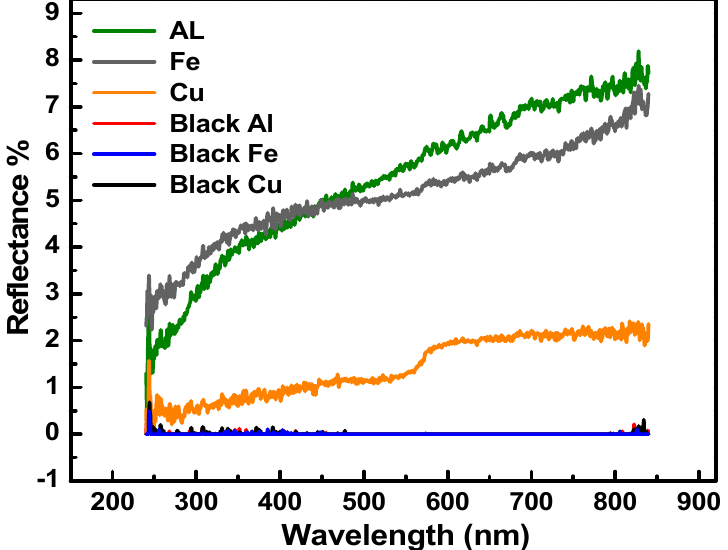
Figure 12. The reflectance % against a wavelength range of 240–840 nm for three pairs of Al, Cu, and Fe non-painted and black-painted surfaces.